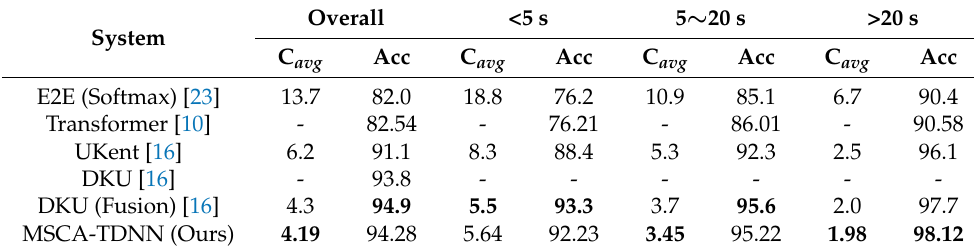
Table 3. Performance comparison of different systems. [C avg and Acc]